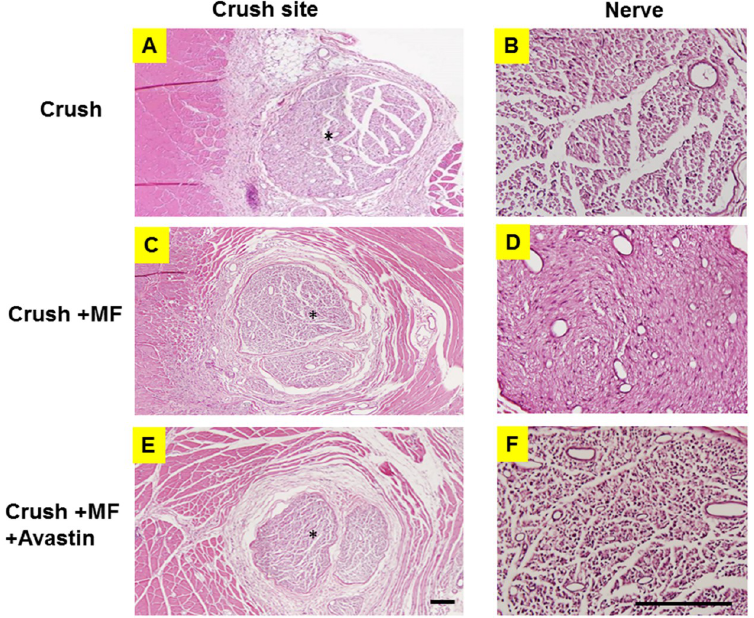
Fig 8. Histomorphology analysis of nerve related to muscle flap. (A) Illustration of crush neve related to muscle flap in the Crush group. (B) Loss of nerve intact structure in the Crush group. (C) Illustration of crushed neve related to muscle flap in the Crush group. (D) Well-organized nerve structure with increased vessel structure in the Crush+ MF group. (E) Illustration of crushed neve related to muscle flap in the Crush+ MF+ Avastin group. (F) Less-organized nerve structure in the Crush+ MF+ Avastin group. � : center of nerve. Arrow bar length = 100 μ m.